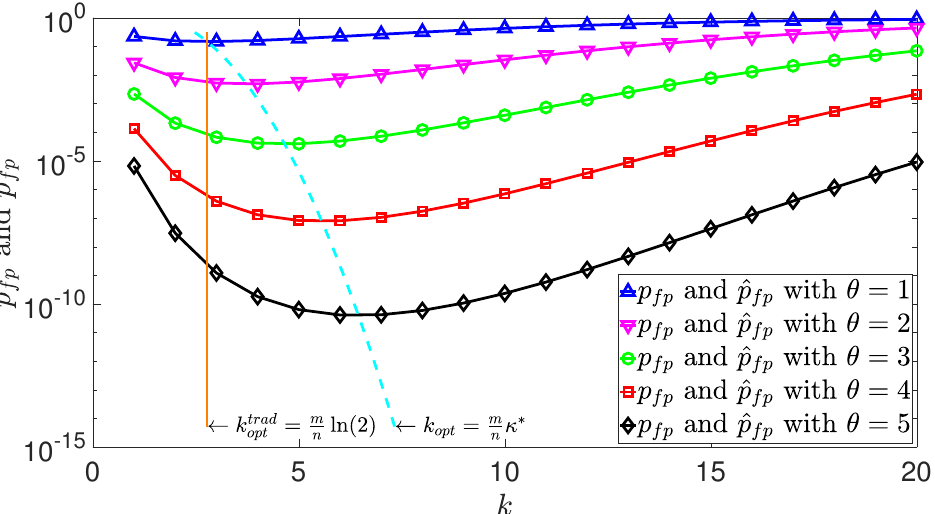
Figure 1. Plot of false positive probabilities with θ = 1 to θ = 5 vs. the number of hash functions k . The ratio m / n is set to four and the cyan dashed line shows k opt ( θ ) . The sample points correspond to p fp and the lines correspond to ˆ p fp . The two functions overlap almost 100 percent.